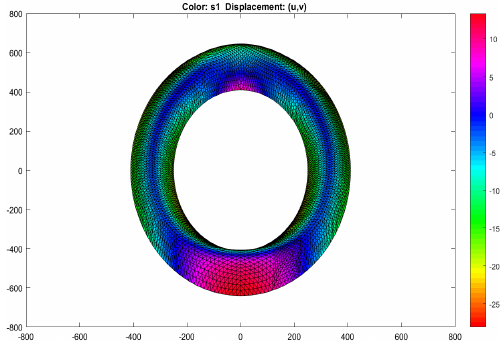
Fig. 5: Plot of the First principal stress.